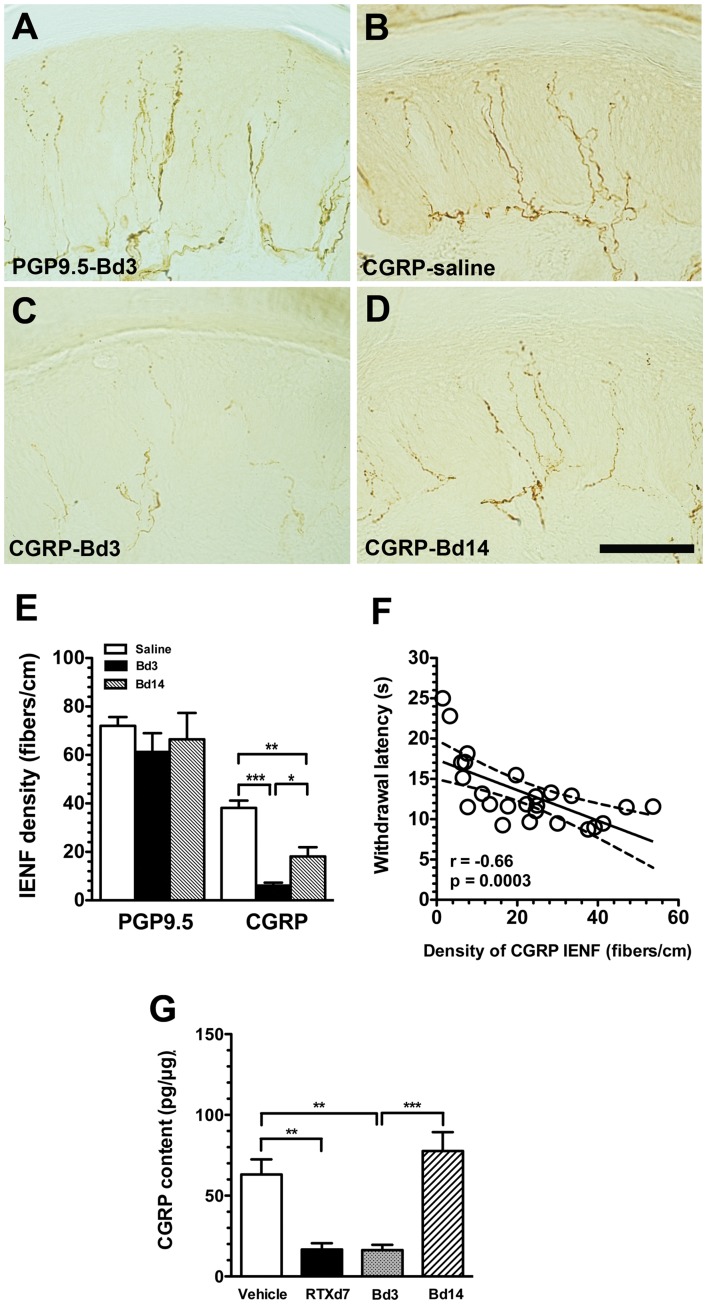
Changes in different phenotypic intraepidermal nerve fibers (IENFs) after an intraplantar injection of botulinum toxin type A (botox) on day 56 of resiniferatoxin (RTX)-induced neuropathy.(A∼D) The figure shows IENFs of protein gene product 9.5 (PGP9.5) on post-botox day 3 (Bd3, A) and calcitonin gene-related peptide (CGRP, B∼D) in the saline group (B), Bd3 (C) and Bd14 (D). (E) IENFs of PGP9.5(+) and CGRP(+) from A∼D were quantified and expressed as the density of IENFs (fibers/cm) (n = 5 for PGP9.5(+) and CGRP(+) IENFs, respectively). (F) Densities of CGRP(+) IENF were inversely correlated with withdrawal latencies on the hot-plate test. (G) The graph shows the changes in CGRP contents of skin with CGRP enzyme immunoassay (EIA) in the vehicle group (open bar, n = 5), on RTX-treatment day 7 (RTXd7) (filled bar, n = 5), Bd3 (gray bar, n = 7) and Bd14 (slash bar, n = 7). The procedures of CGRP EIA were following the manufacturer instructions and CGRP content was normalized to the protein content of epidermis. The CGRP contents were compared with the one-way ANOVA test. Bar, 100 µm; *p<0.05, **p<0.01, ***p<0.001.